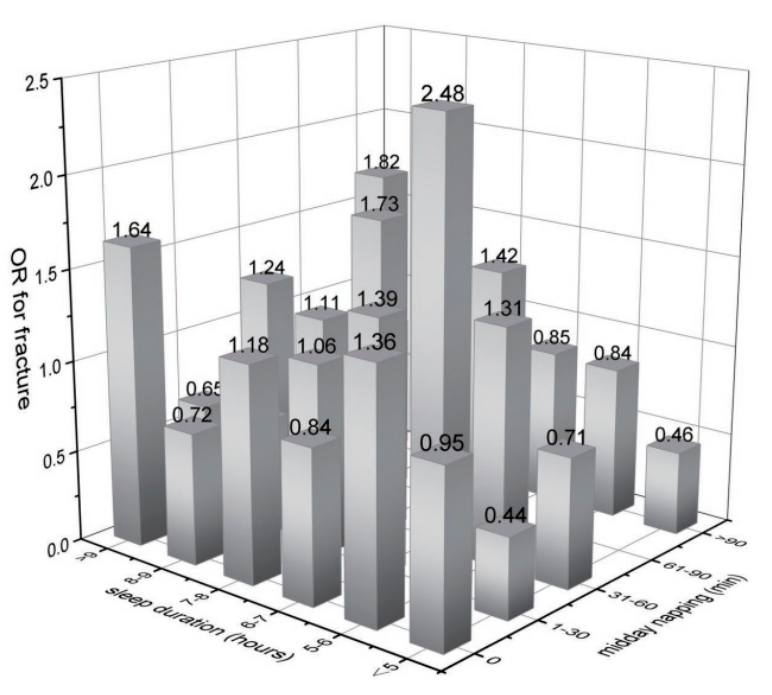
Figure 4. Forest plot of logistic regression analysis of midday napping and risk of hip fracture strat- ified by baseline information.